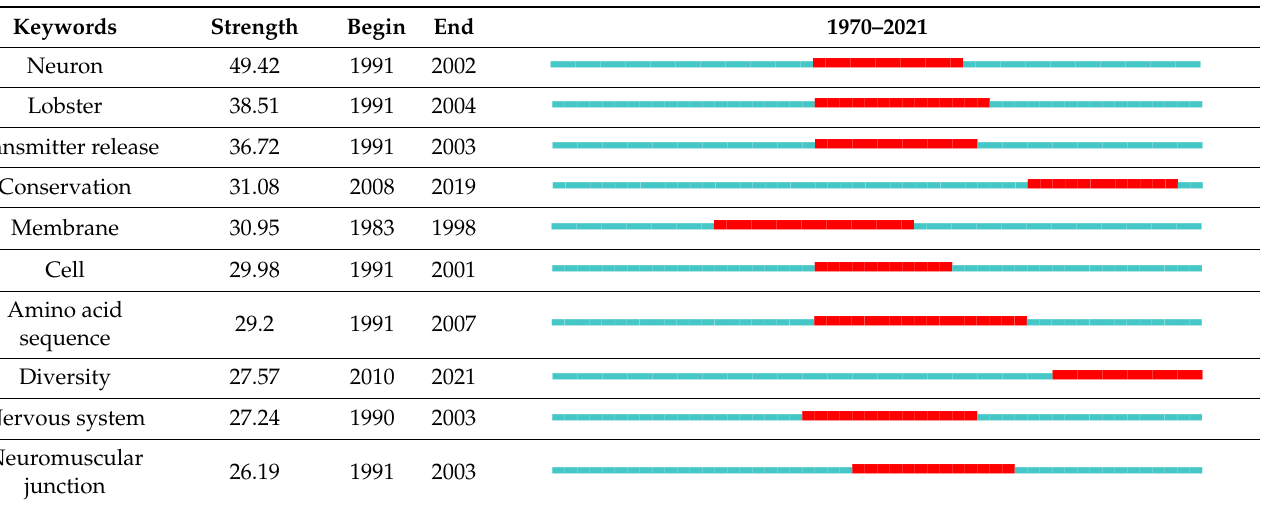
Table 10. Top 10 keywords with strongest citation bursts for the period from 1970 to 2021. Red sections in the timelines represent the period of the burst.